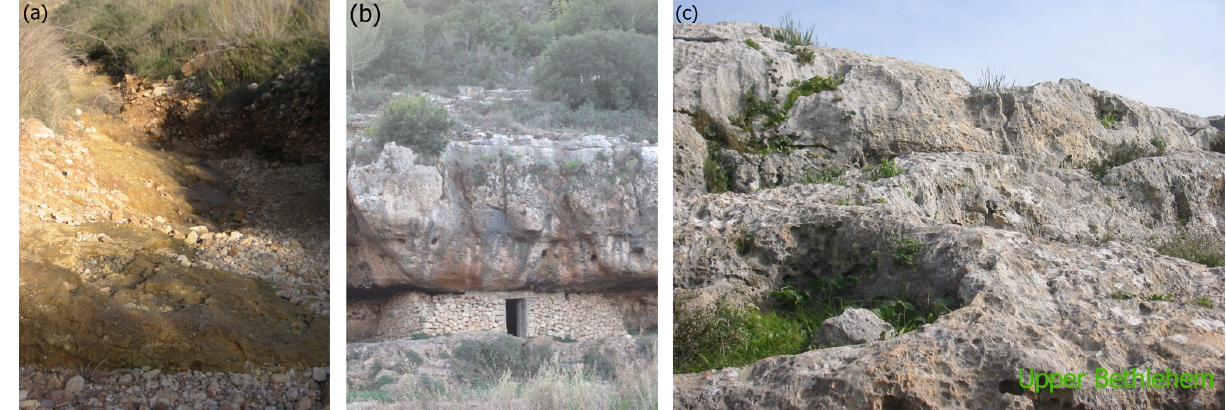
Figure A1. Formation outcrops. Rare outcrops of yellow marls, forming the main regional aquiclude (upper Yatta formation) near Ras Karkar (a) ; reefal limestone cliff at Wadi Zarqa (u-UBK formation) with high primary porosity and the development of karst and epikarst (b) ; karstic karren landscape (upper Bethlehem formation) with a relatively rare example of discontinuous soil cover (soil pockets) in Wadi Natuf (c) .